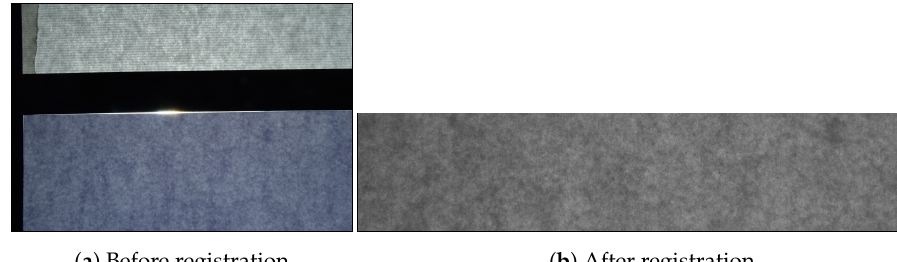
Figure 4. Document acquisition with BIT before ( a ) and after registration ( b